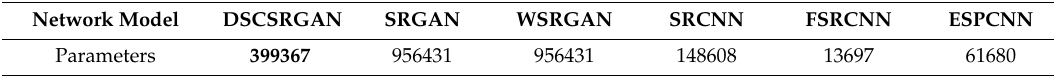
Table 1. Parameters of di ff erent network